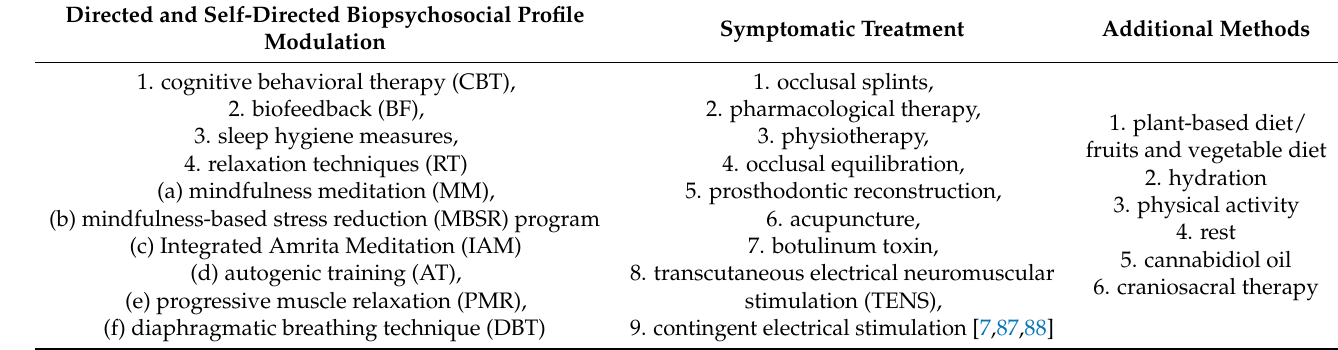
Table 4. MPS treatment